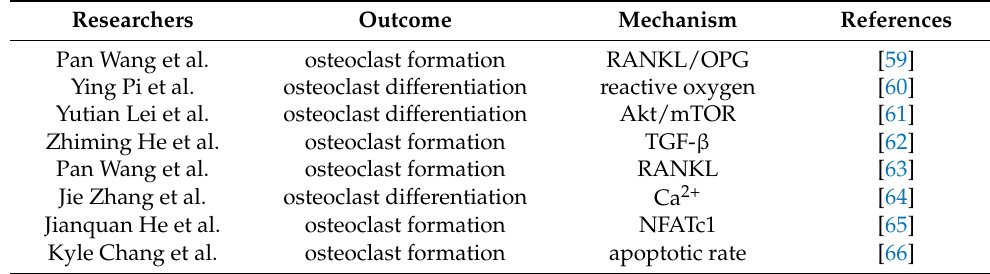
Table 3. PEMFs inhibit the progression of osteoporosis by affecting